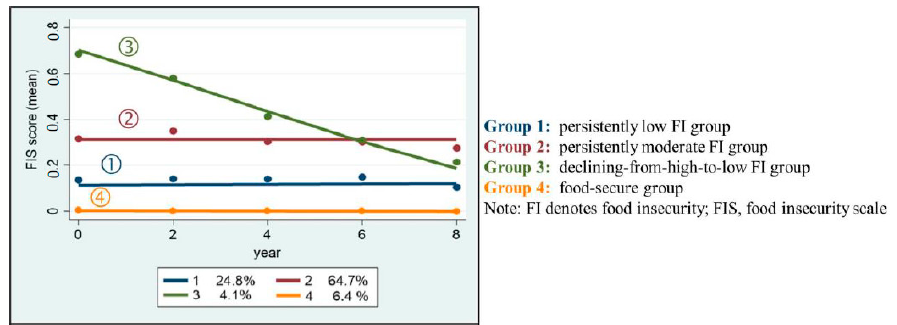
Figure 1. Food insecurity trajectories over